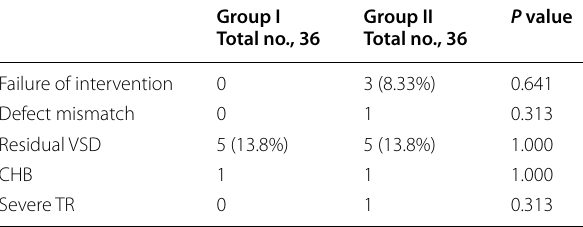
Table 3 Comparison of intra‑procedure complications between groups I and II